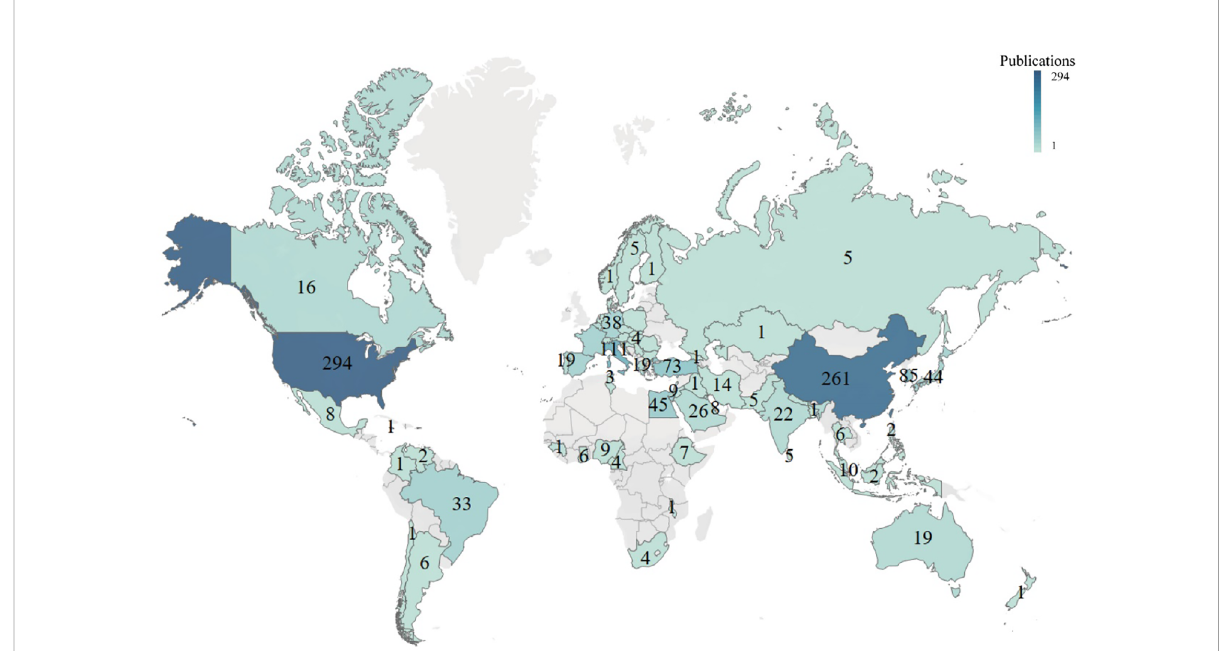
FIGURE 3 Analysis of the global research trends based on the origins of the